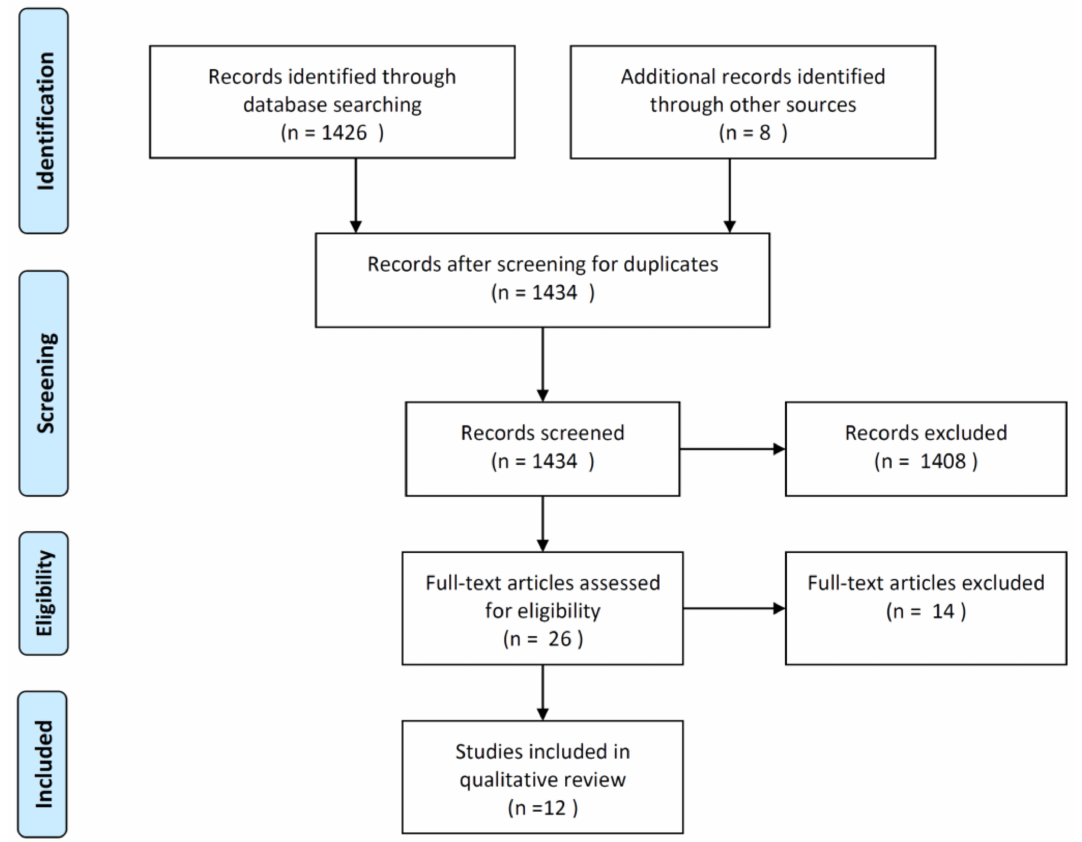
Figure 1. Flow of literature identification, screening, eligibility assessment, and inclusion in our review study of risk of second cancer in patients with chronic myeloproliferative neoplasms. Included studies provided data on cancer occurrence after MPN diagnosis compared either to matched general population controls or to cancer incidence statistics from general population